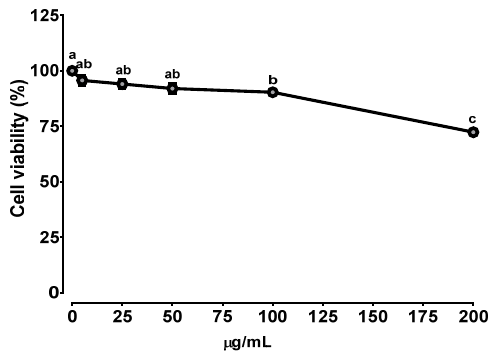
Figure 1. Cytotoxicity of polyphenol-rich black elderberry extract (BEE)-treated Caco-2 cells. Cells were treated with increasing concentrations (0–200 μ g/mL) of BEE for 24 h. The viability (%) is presented relative to controls without BEE treatment. Data with different letters are significantly different ( p < 0.05). Values are means ± SEM; n = 6.